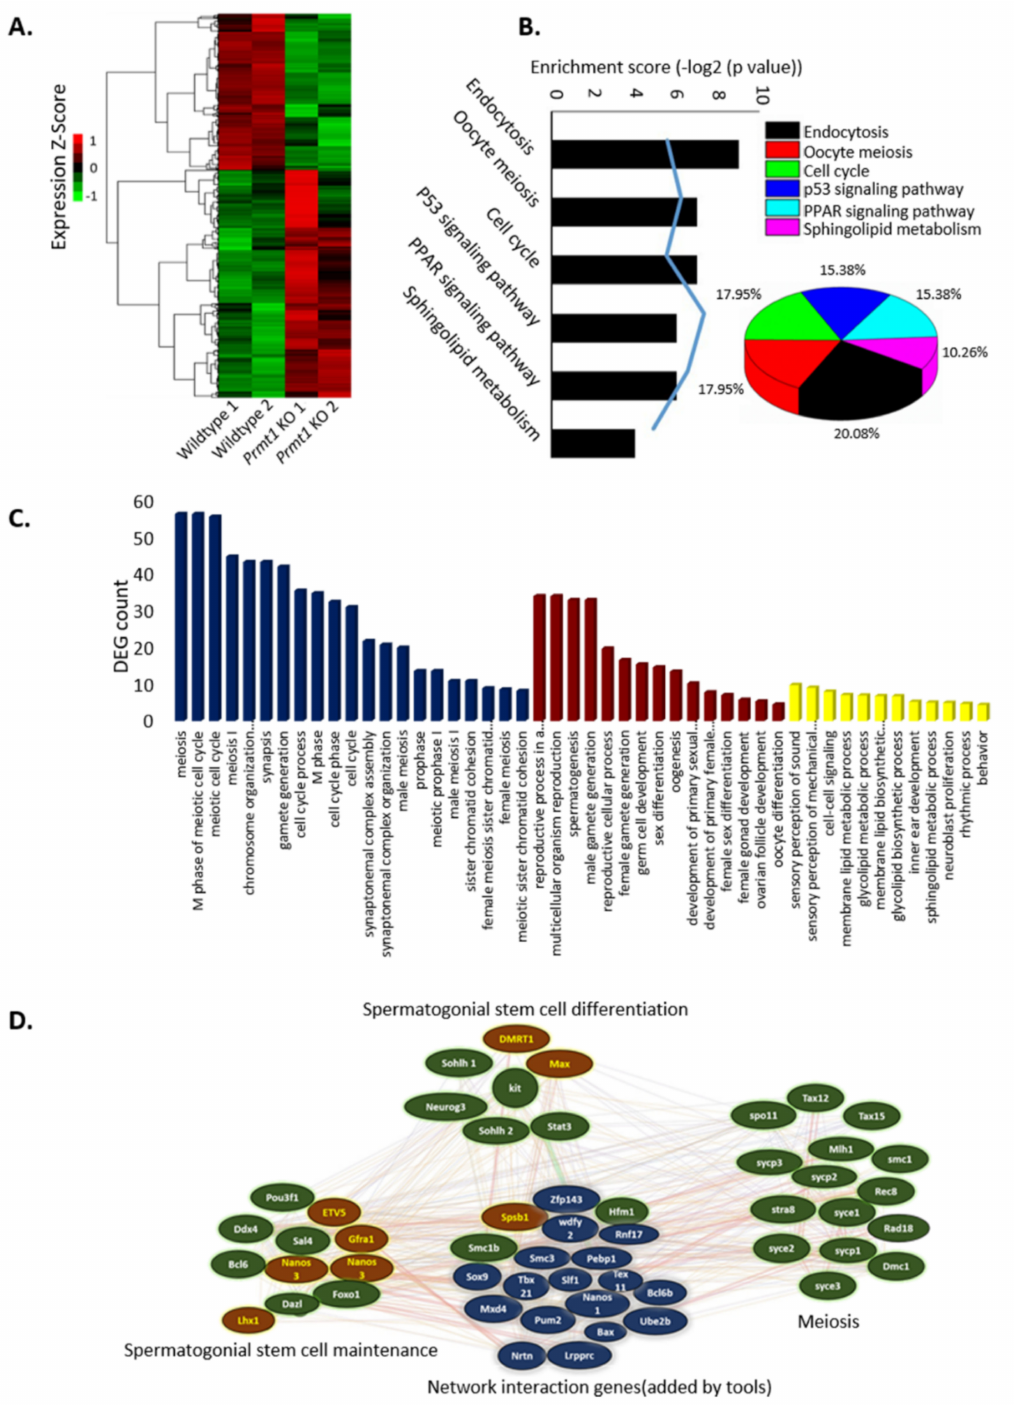
Figure 3. PRMT1 deletion alters the expression pattern of genes involved in mouse spermatogenesis. ( A ) Heatmap showing the differentially expressed genes between the wildtype and Prmt1 KO testes on P8 and their functional enrichment. Two-fold expression difference and p = 0.05 as the cut-off. ( B ) Top-enriched Kyoto Encyclopedia of Genes and Genomes (KEGG) pathways of the downregulated differentially expressed genes (DEGs). Bar represents -log2 P value and blue line represents the DEG count. ( C ) Gene ontology enrichment analysis of biological processes for the downregulated genes between the wildtype and Prmt1 KO testes. Meiosis-related genes are represented in blue, developmental process genes are in red and miscellaneous in yellow. ( D ) The interaction network of genes involved in spermatogenesis. Upregulated (red), downregulated (green), and unchanged genes